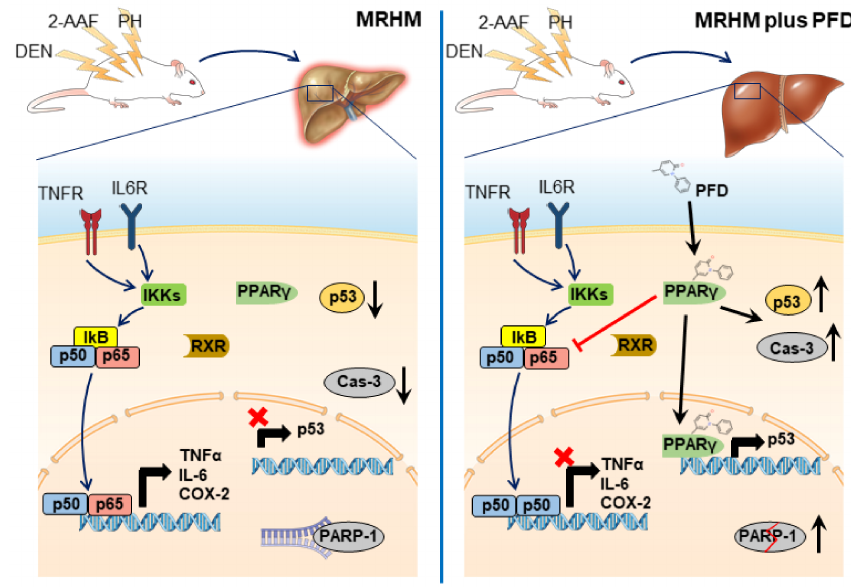
Figure 8. Summary mechanism of action of PFD in the early stages of HCC. Left panel: